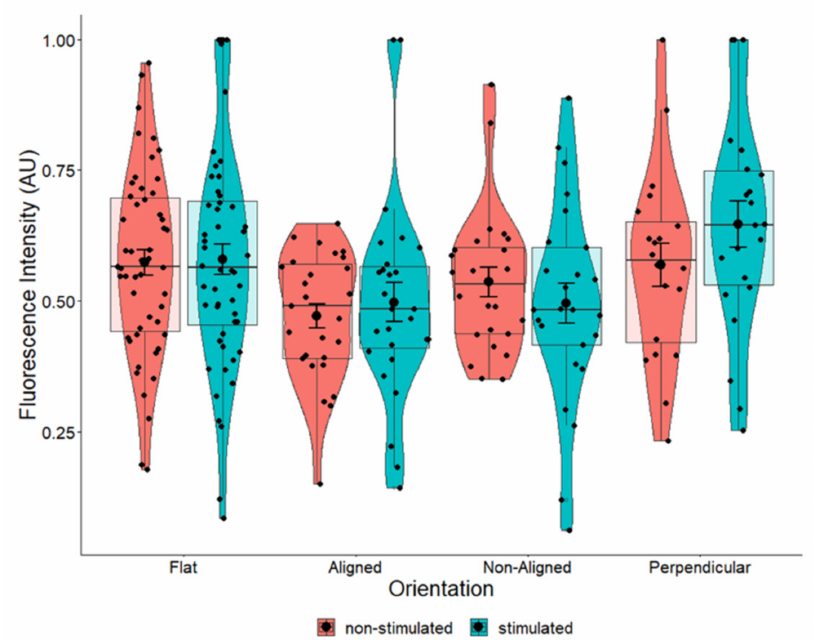
Figure 10. Pair-wise comparison of BDNF expression in SH-SY5Y cells with and without ES grown on flat cover slips, aligned fibers aligned with EF, non-aligned fibers, and aligned fibers perpendicular to the EF. One-way ANOVA for flat p = 0.857, aligned p = 0.551, non-aligned p = 0.407, and perpendicular